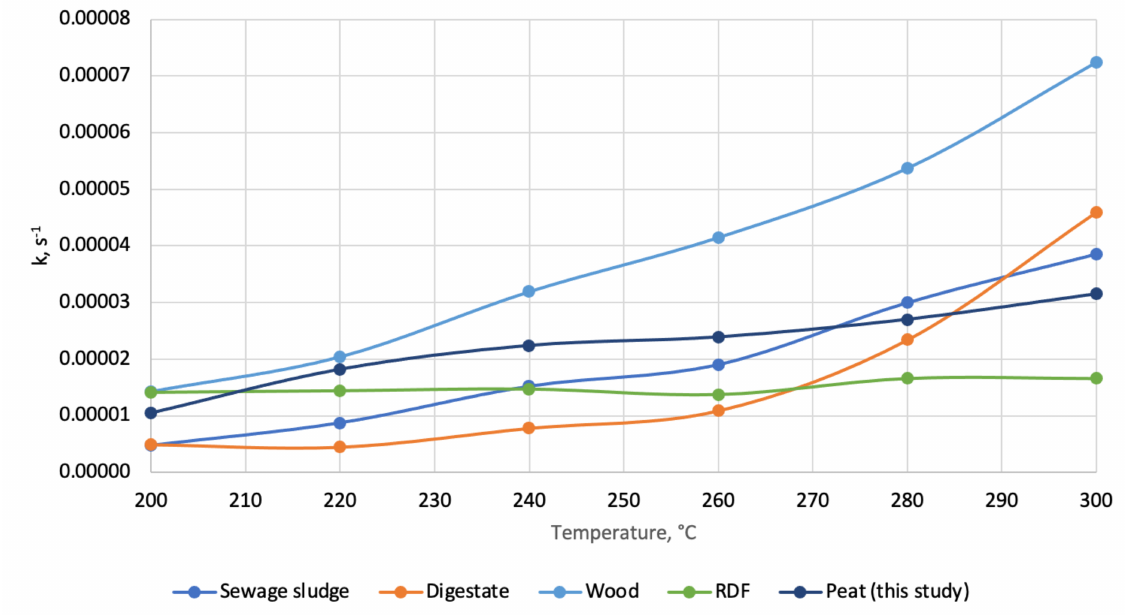
Figure A3. The constant reaction rates (k) in function of temperature for different materials at specific temperatures